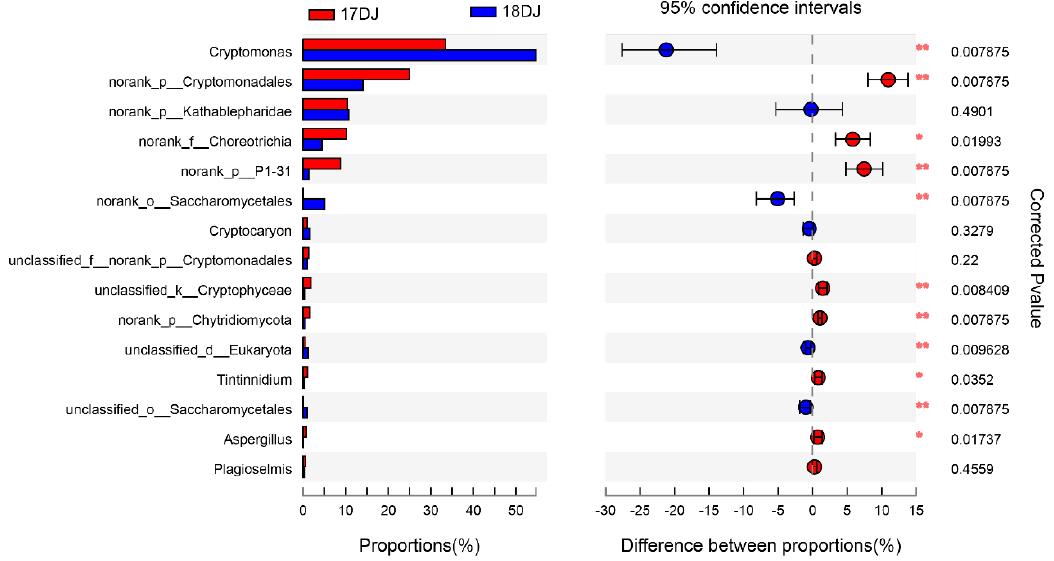
Figure 6. Analysis of significant differences between groups. (* indicates significant correlation at the 0.05 level; ** indicates significant correlation at the 0.01 level; *** indicates significant correlation at the 0.001 level).